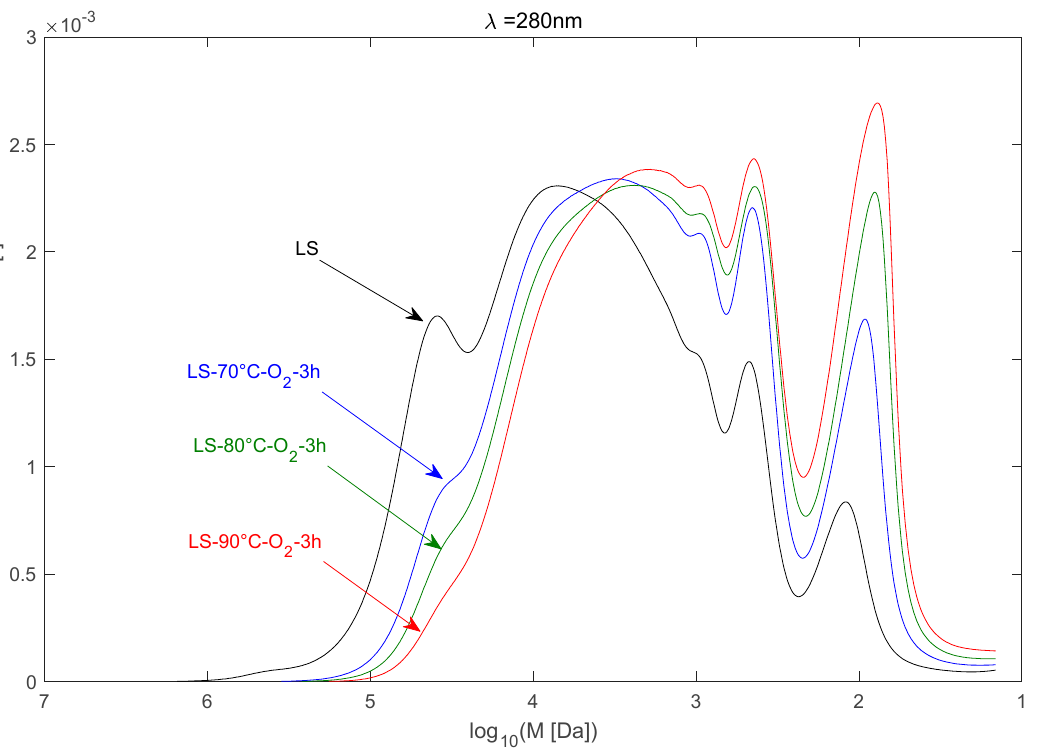
Figure 3. Molecular weight distribution of raw and depolymerized LS as a function of the reaction temperature (time = 3 h).